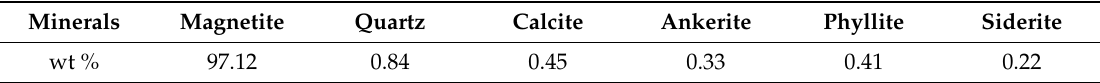
Table 4. Minerals compositions of pure